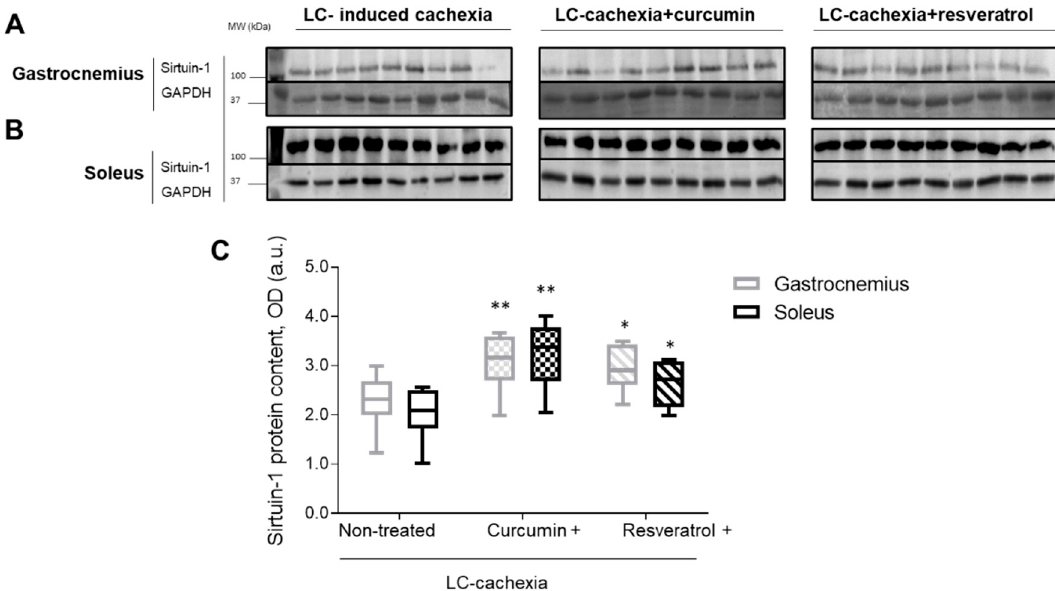
Figure 4. Representative immunoblots of sirtuin-1 and GAPDH proteins in the gastrocnemius ( A ) and soleus ( B ) muscles of all study groups of mice. Definition of abbreviations: MW, molecular weight; kDa, kilodalton; OD, optical densities; a.u., arbitrary units; LC, lung cancer; GAPDH, glyceraldehyde-3-phosphate dehydrogenase; ( C ) box plots of sirtuin-1 protein content in gastrocnemius and soleus muscles of the different study groups of mice, as measured by optical densities in arbitrary units (OD, a.u.). Statistical significance is represented as follows: *, p ≤ 0.05; **, p ≤ 0.01 between any of the study groups and the LC-induced cachexia mice in gastrocnemius and soleus muscles.